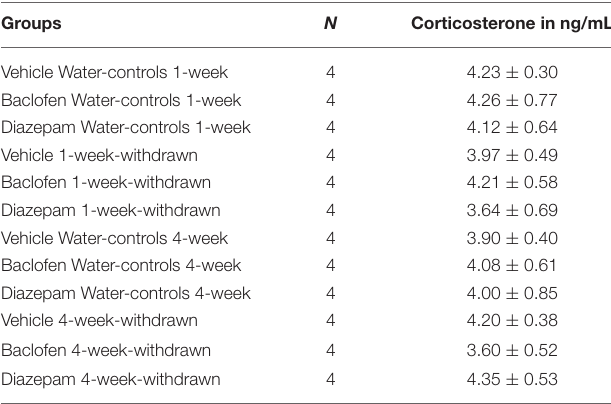
TABLE 2 | Basal corticosterone concentrations (ng/mL) in naïve condition in the in the dorsal hippocampus.